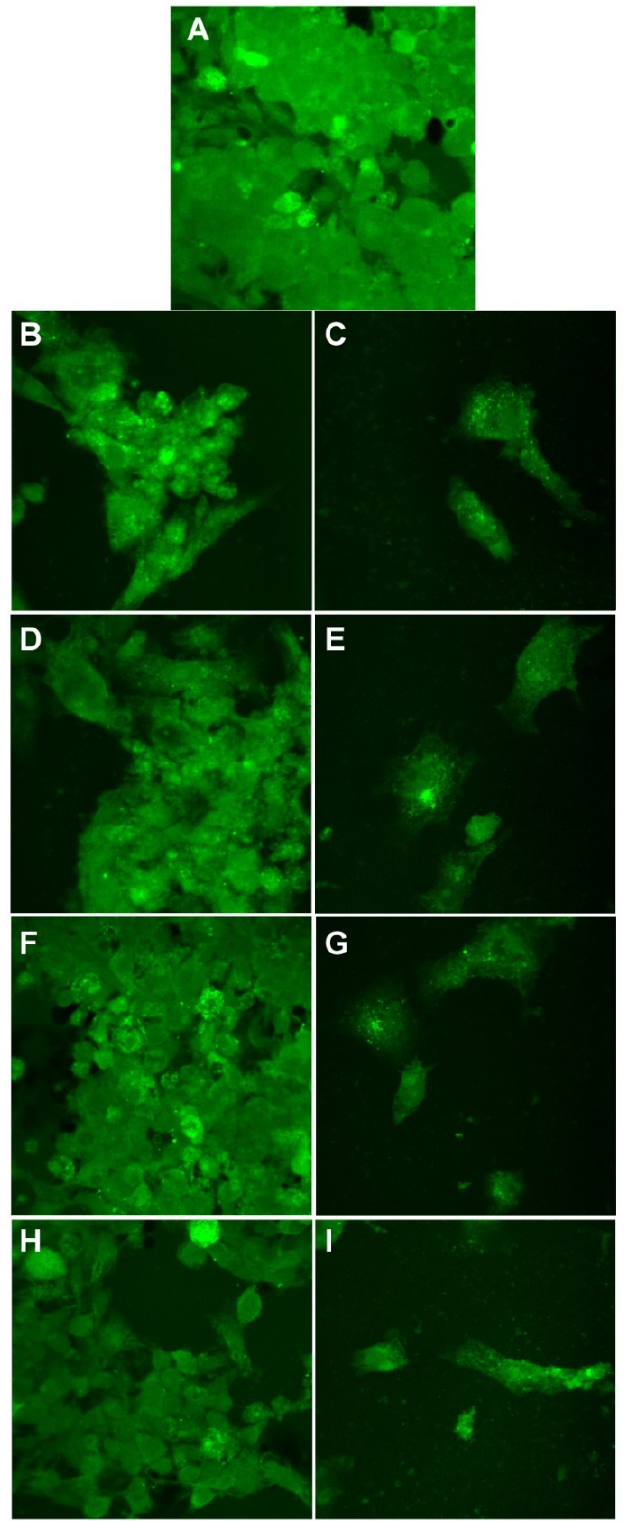
Figure 13. Morphological evaluation of HepG2 cells treated with Tur-nAg/AgCl ( B , C ), Tur- nAg/AgCl–Lip ( D , E ), Tur-nAg/AgCl–CTS ( F , G ), and Tur-nAg/AgCl–Lip–CTS ( H , I ) at two different concentrations: 12.8 mg/mL and 51.1 mg/mL, respectively, compared with control cells ( A ).